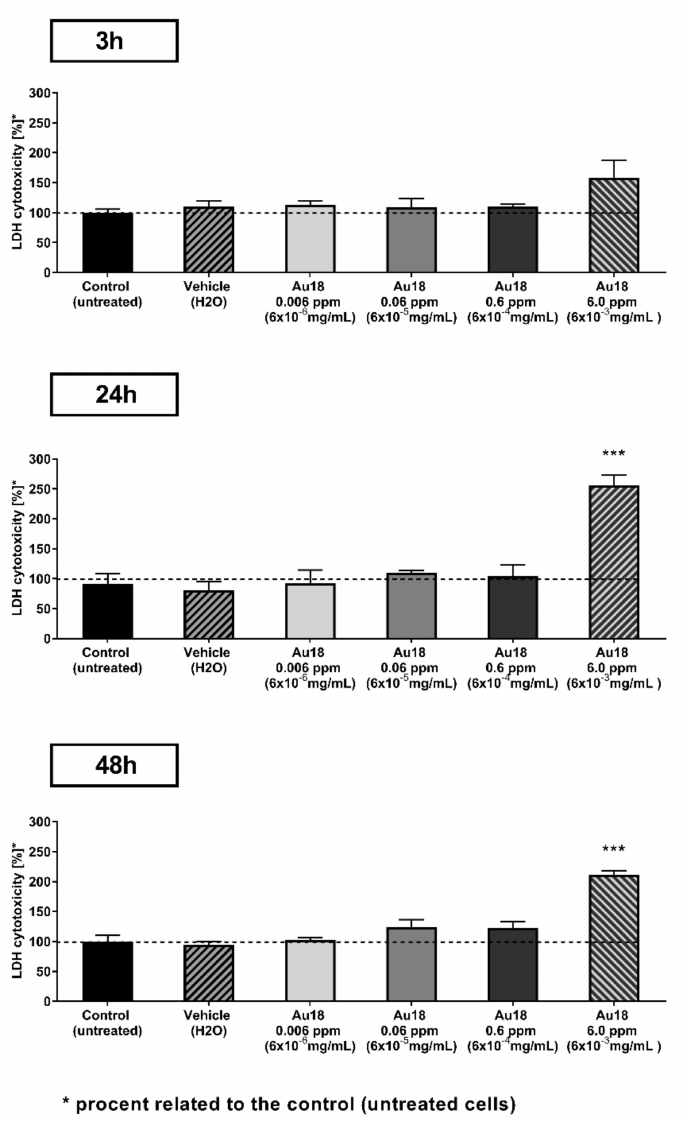
Figure 2. Cytotoxicity of Au18 NCs on P19 cells in lactate dehydrogenase (LDH) test. P19cells were incubated with culture medium containing NCs at concentrations between 0.006 ppm to 6.0 ppm and were compared to vehicle (H 2 O) treated cells (negative control) at 3, 24 and 48 h. Non-treated cells were also reported as no effect of vehicle was observed. Each experimental group consisted of n = 3 independent samples and error bars represent standard error of means. *** p < 0.001 as compare to vehicle treated